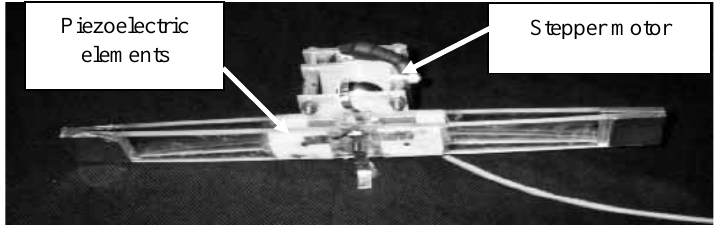
Fig. 2. Experimental beam-like